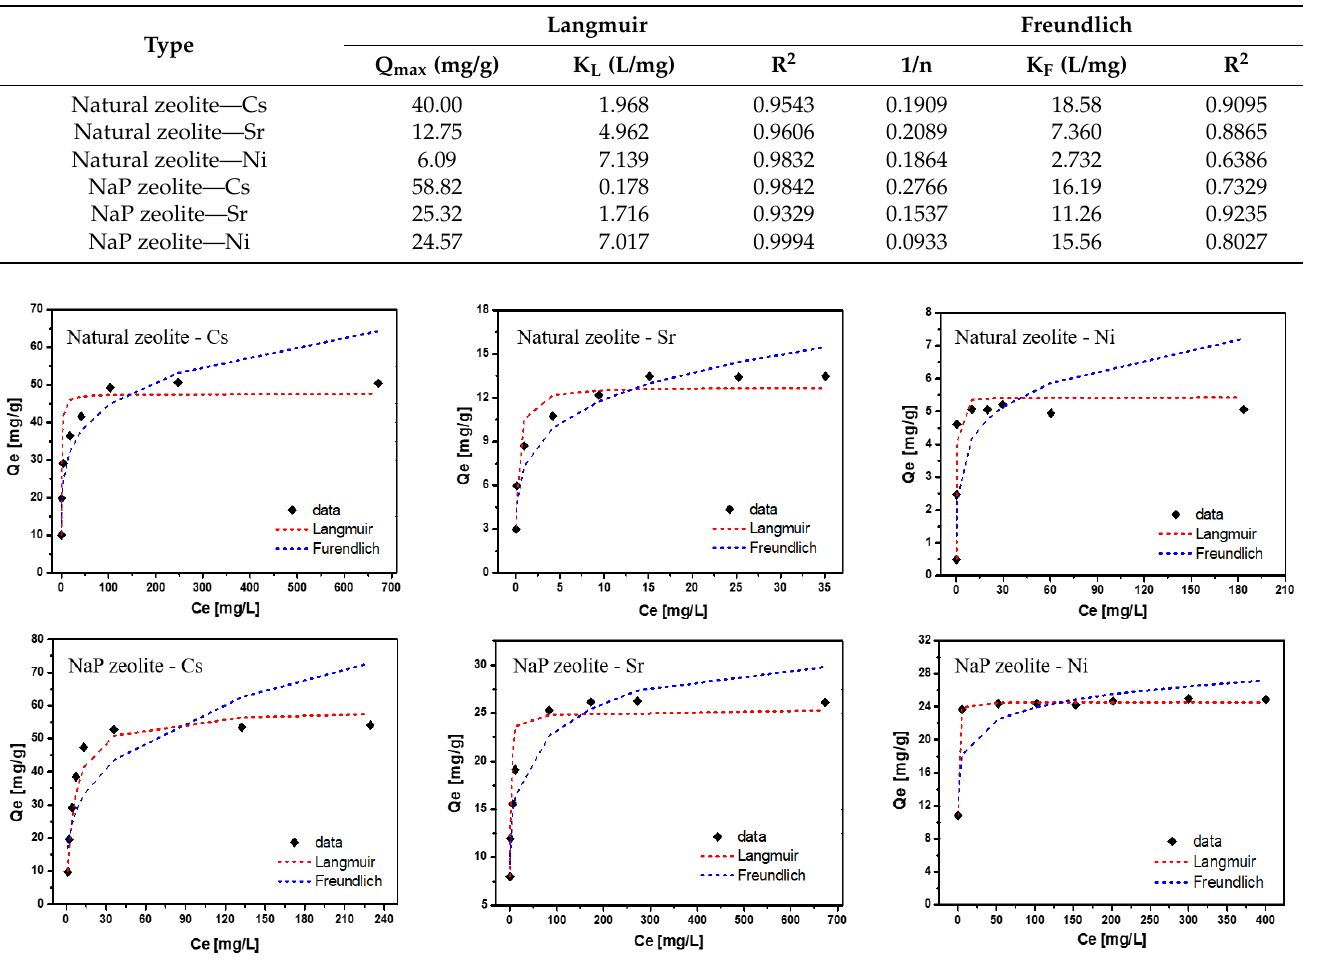
Table 2. Fitting parameters of Langmuir and Freundlich adsorption isotherms.